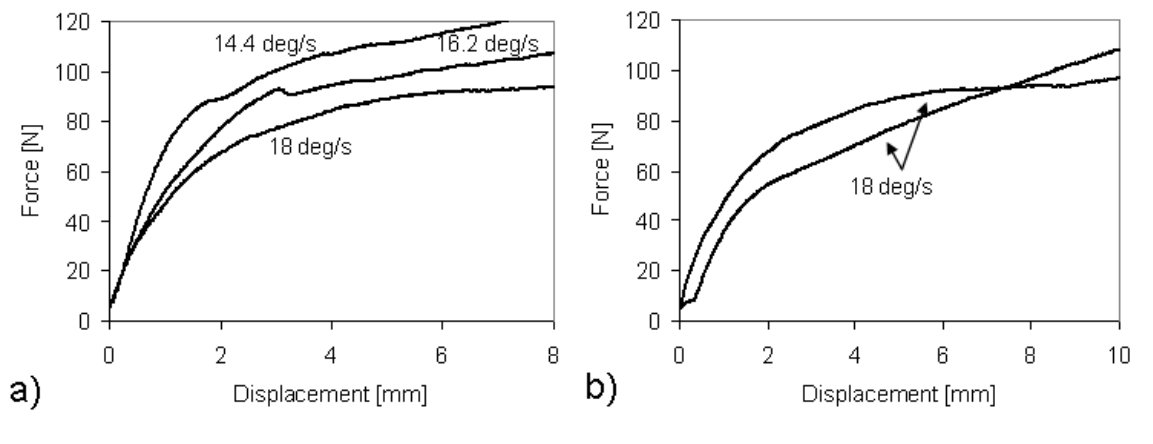
Figure 6. (a) Effect of the winding speed on the compression test and (b) reliability of the results at the highest winding